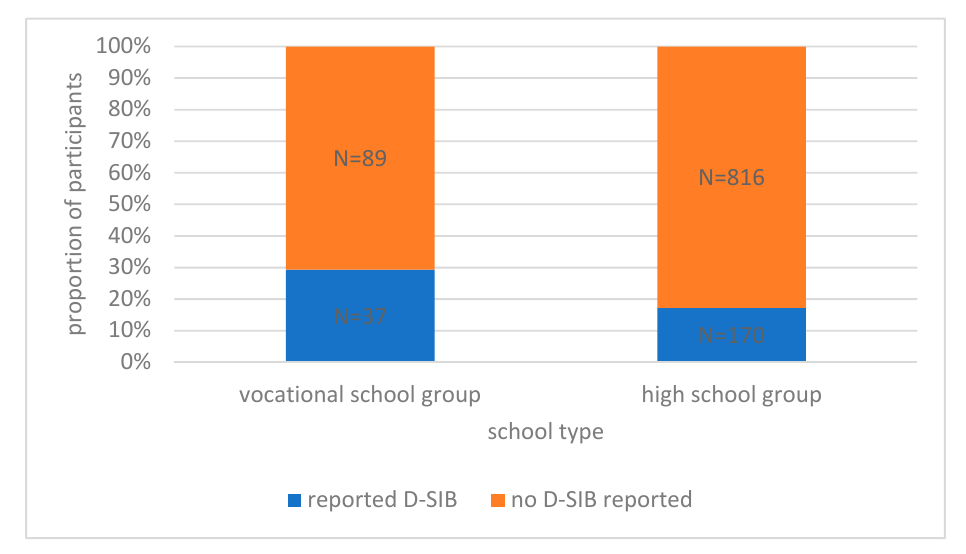
Figure 1. Lifetime prevalence of D-SIB in vocational school and high school groups.